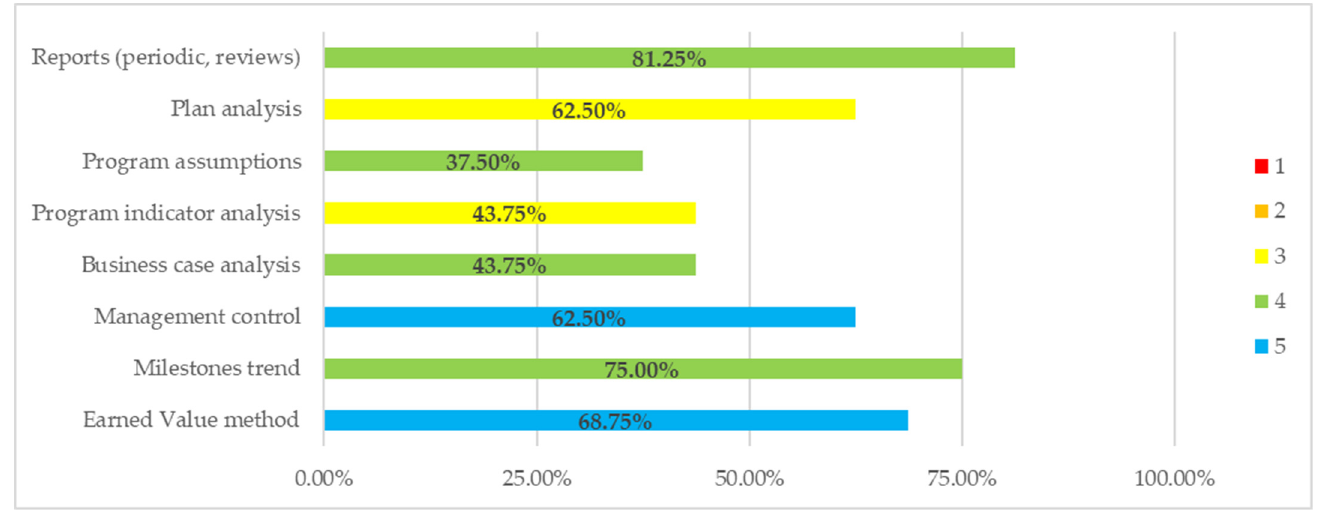
Figure 4. Evaluation of the effectiveness of the methods, techniques and tools used for the scope control process. Source: own elab.